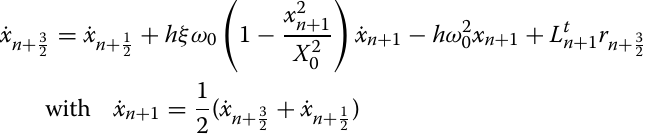
For CD-Lagrange equilibrium (37), the velocity in damping term is taken at t modification makes the damping term explicit. The Moreau–Jean equilibrium (38) is solved by a Newton’s algorithm being